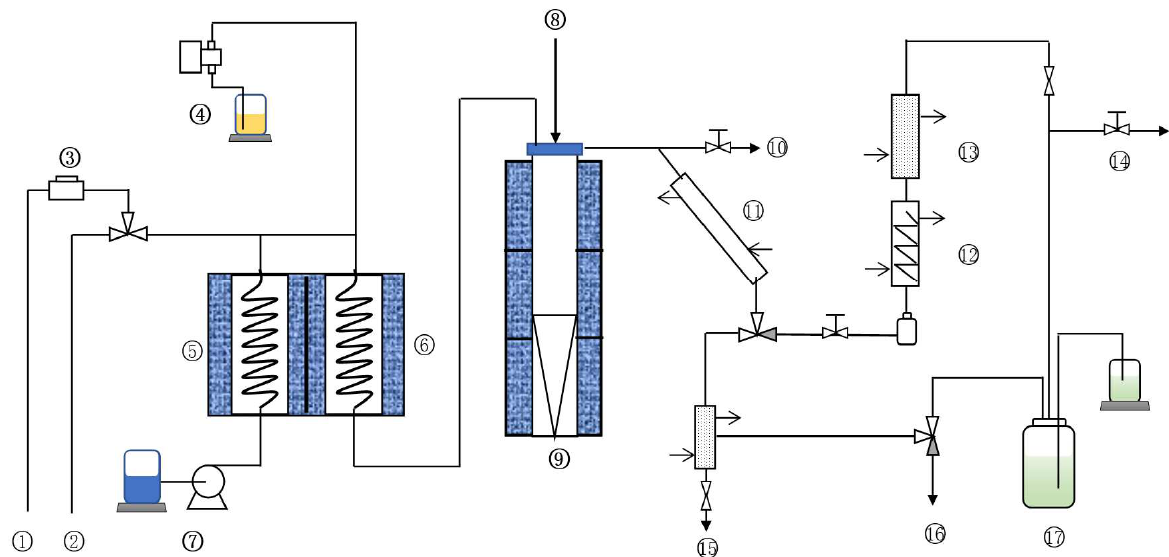
Figure 7. Flow chart of small fixed-fluidized bed catalytic cracking test unit. ① Oxygen. ② Air. ③ Flow meter. ④ Oil pump. ⑤ Gasifier. ⑥ Preheating oven. ⑦ Water pump. ⑧ Catalyst inlet.